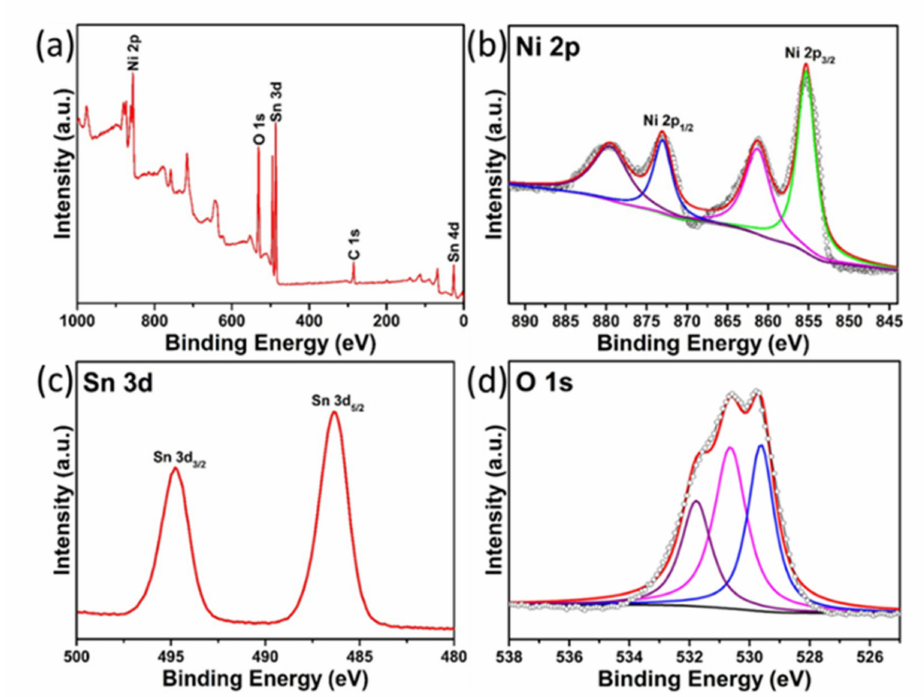
Figure 5. XPS spectra of the SnO 2 / NiO nanocomposite: ( a ) survey spectrum; ( b ) Ni 2p; ( c ) Sn 3d; ( d ) O 1s.